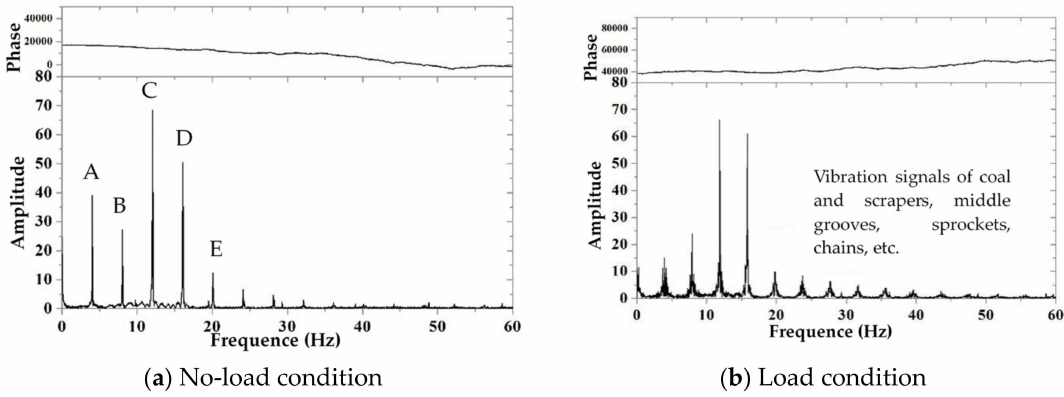
Figure 13. Spectrograms of vibration signals under no-load and load